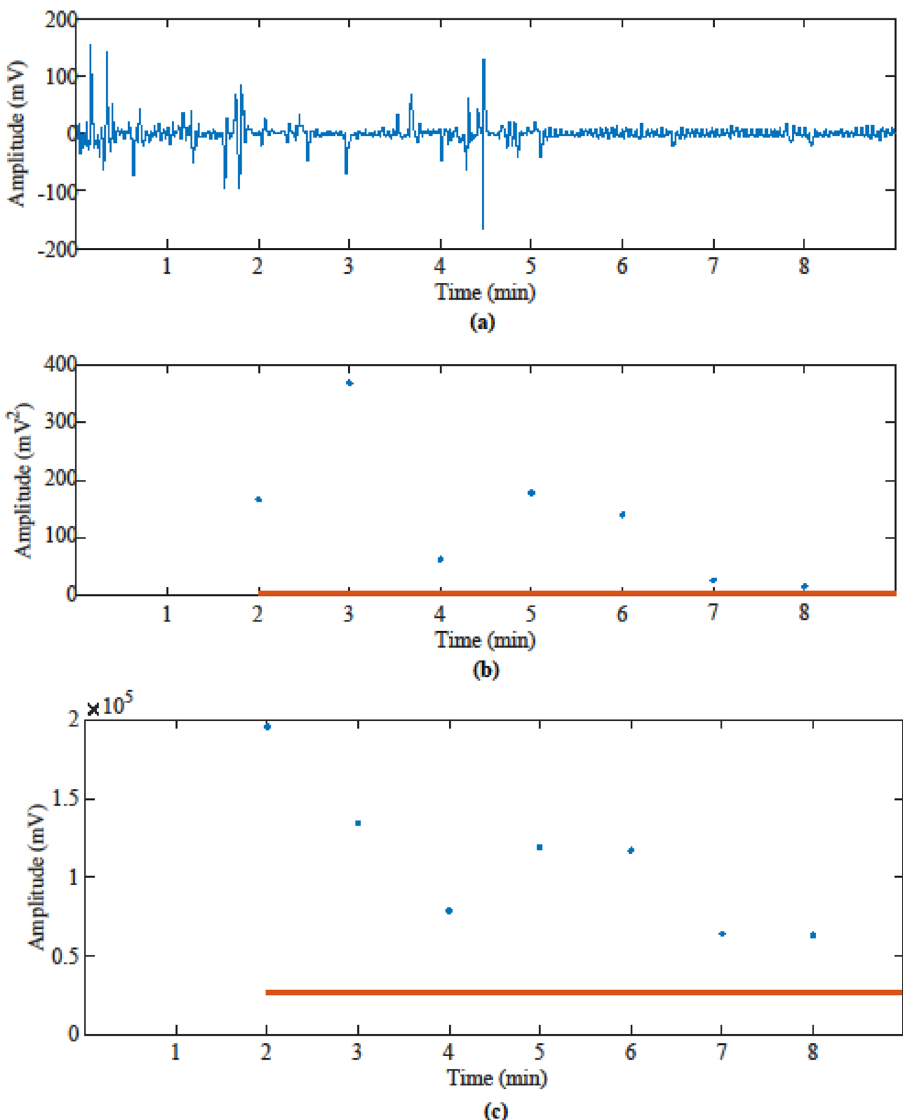
Figure 3. Ceiling Mounted TruePODS sensor detects a person hiding under table: ( a ) filtered radar signals after static-background being removed; ( b ) band power results (blue dots) are consistently above the band power threshold (red line), so occupancy was accurately detected 100% of the time using the BP algorithm, ( c ) Riemann Integral results (blue dots) are consistently above the RI threshold (red line), so occupancy was accurately detected 100% of the time using the RI